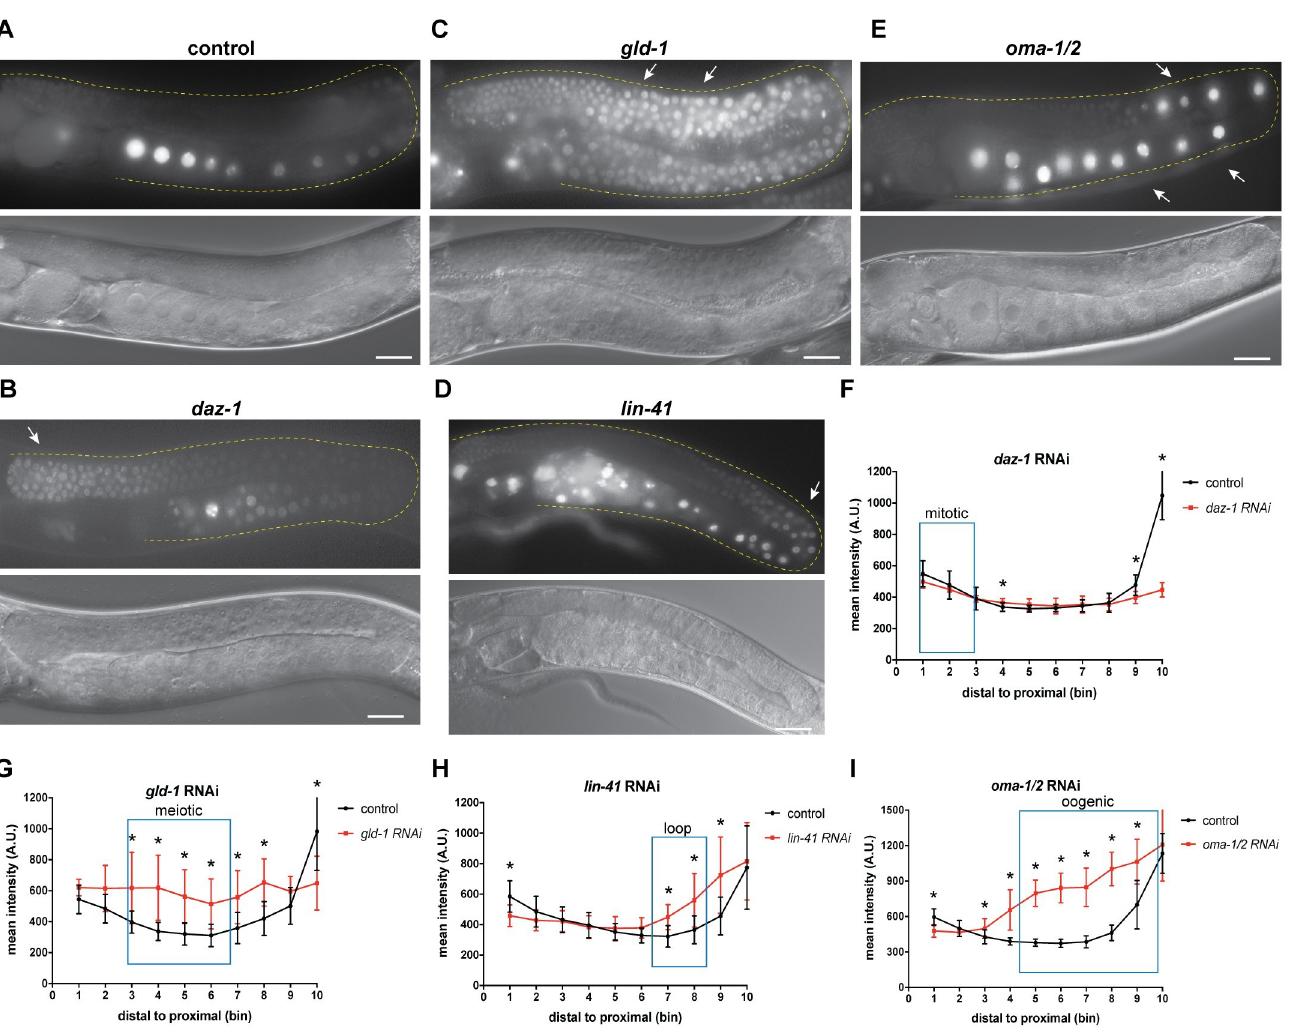
Fig 5. GLD-1, OMA-1/2, and LIN-41, but not DAZ-1 regulate spatiotemporal expression pattern of MEX-3 in the germline through the 3´UTR. (A) DIC and fluorescence images of Pmex-5 :: MODC PEST :: GFP :: H2B :: mex-33´UTR animals from the control RNAi. (B) DIC and fluorescence images of Pmex-5 :: MODC PEST :: GFP :: H2B :: mex-3 3´UTR animals after daz-1 knockdown. daz-1 knockdown didn´t cause increased reporter expression in the distal mitotic end. (C) DIC and fluorescence images of the transgenic reporter after gld-1 knockdown. gld-1 knockdown caused an overall increased expression of the reporter. (D) DIC and fluorescence of the transgenic reporter after lin-41 knockdown. lin-41 knockdown caused increased reporter expression in the loop region. (E) DIC and fluorescence images of transgenic reporter after oma-1/2 knockdown. oma-1/2 knockdown caused increased reporter expression in the oocytes [41]. (F) quantitative analysis of the reporter fluorescence intensity after daz-1 knockdown (n = 10/10). (G) quantitative analysis of the reporter fluorescence intensity after gld-1 knockdown (n = 8/ 8). (H) quantitative analysis of the reporter fluorescence intensity after lin-41 knockdown (n = 8/8). (I) quantitative analysis of the reporter fluorescence intensity after oma-1/2 knockdown (n = 14/14). ( � ) indicates statistical significance, p-value � 0.05. All p-values for this figure are reported in S5 Table. Scale bar = 30 μ